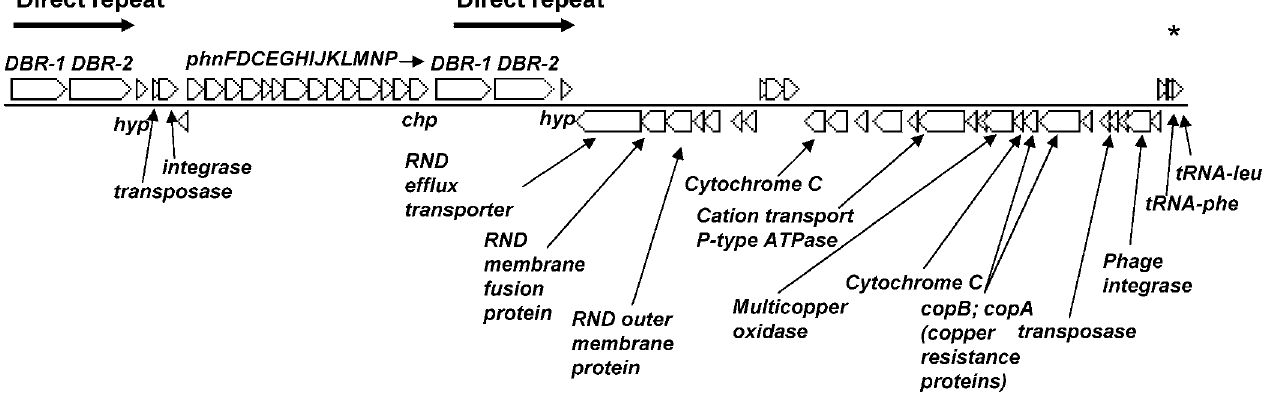
Figure 8. Thiom. crunogena XCL-2 Phosphonate Operon The DBR-1 genes are identical to each other, as are the DBR-2 genes. Gene abbreviations are: chp , conserved hypothetical protein; DBR-1 and - 2 , DNA breaking-rejoining enzymes; hyp , hypothetical protein; phnFDCEGHIJKLMNP , phosphonate operon. An asterisk (*) marks the location of a region (within and upstream of tRNA-phe) with a high level of similarity to the 5 9 ends of the two direct repeat sequences noted in the figure. The transposase and integrase are actually a single CDS separated by a frameshift. DOI: